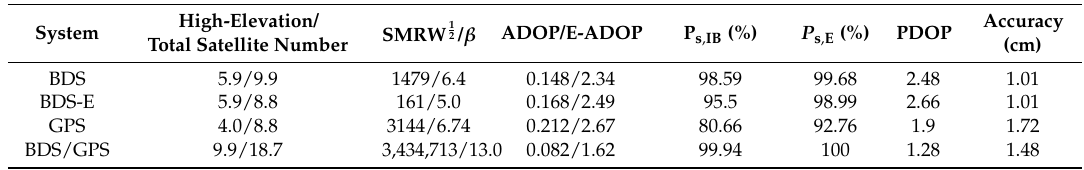
Table 7. Results of BDS, BDS-E, GPS and BDS/GPS.